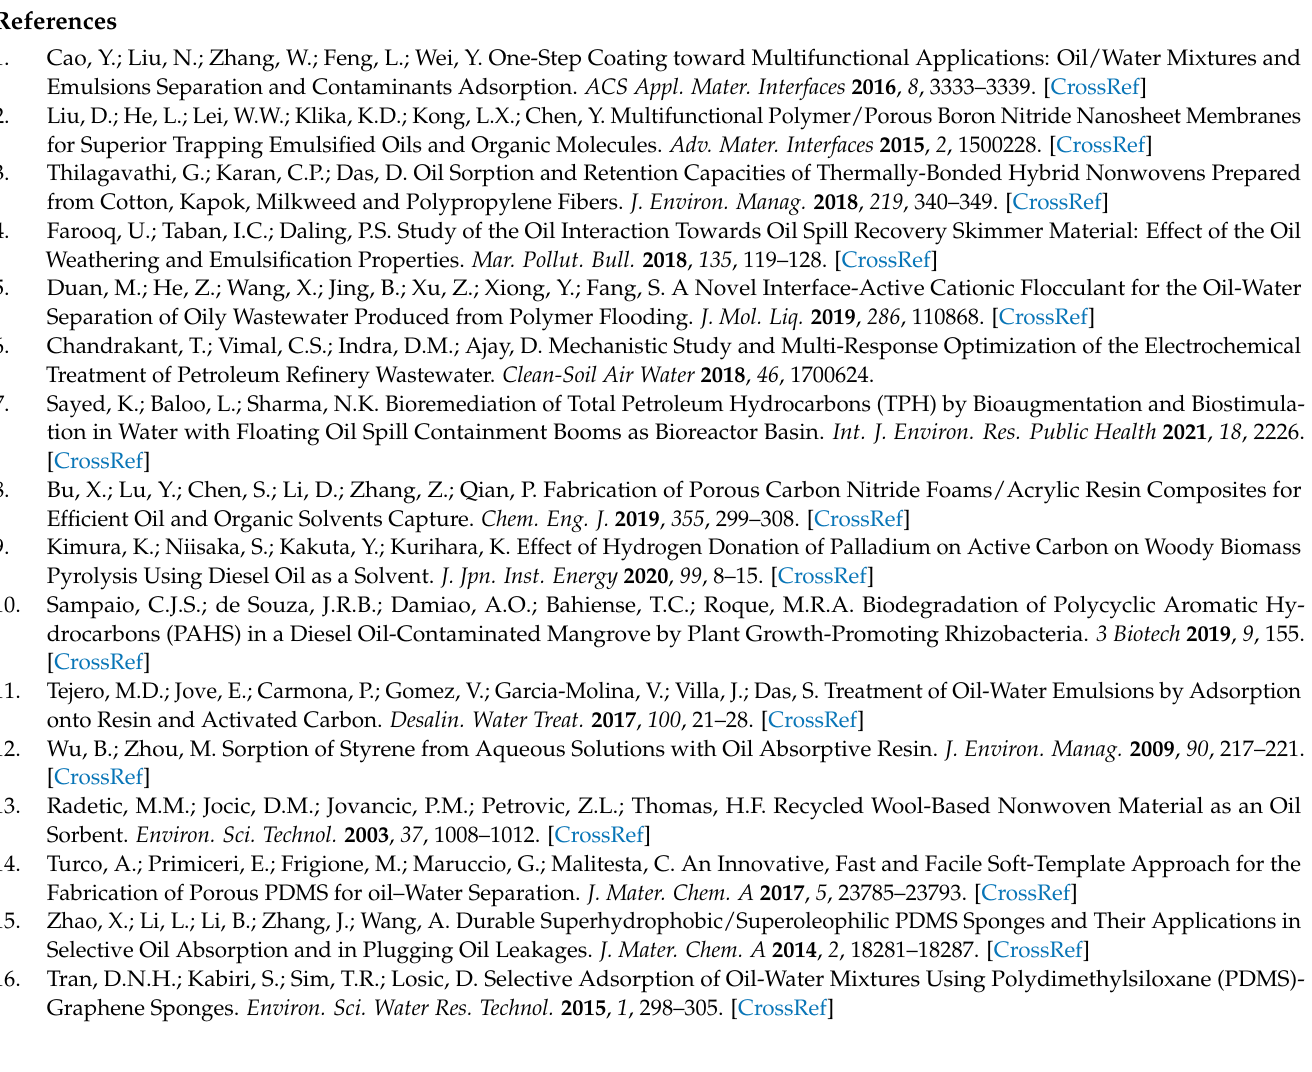
Figure S9. Compressive stress-strain curves of PDMS, CNT-PDMS, and PDA/CNT-PDMS sponges at the maximum strain of 80%., Figure S10. Photographs (a 1 –c 1 ) of PDMS, CNT-PDMS, PDA/PDMS and PDA/CNT-PDMS sponges (from left to right) in toluene/water emulsion for 10 min (a 1 ), 30 min (b 1 ) and 50 min (c 1 ) and the corresponding optical images (a 2 –a 5 , b 2 –b 5 , c 2 –c 5 ) of